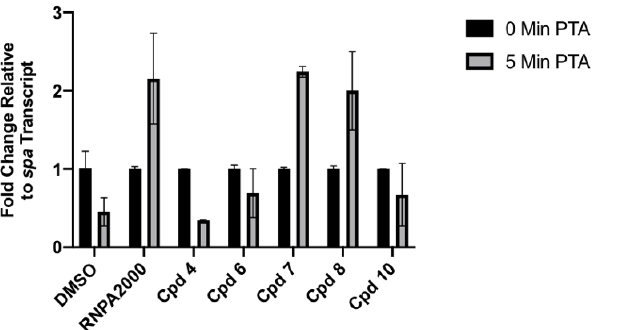
Figure 8. RT-PCR of spa transcript turnover. S. aureus UAMS-1 cells were treated with 0.5× MIC of each compound for 30 min prior to transcriptional arrest (PTA). Each compound was evaluated twice, and values were averaged.